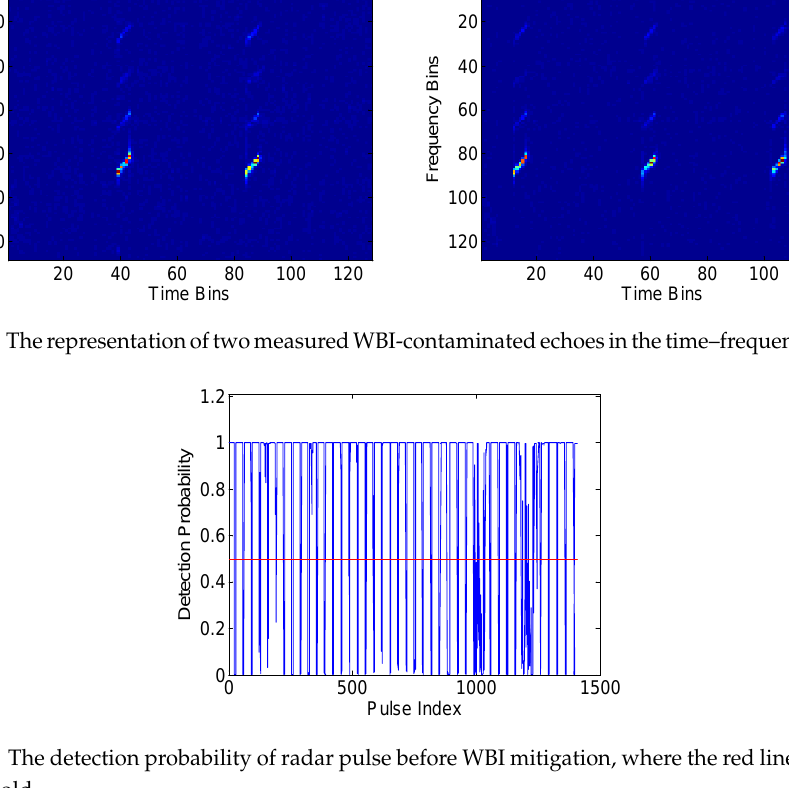
Figure 19. The detection probability of radar pulse before WBI mitigation, where the red line represents the threshold.